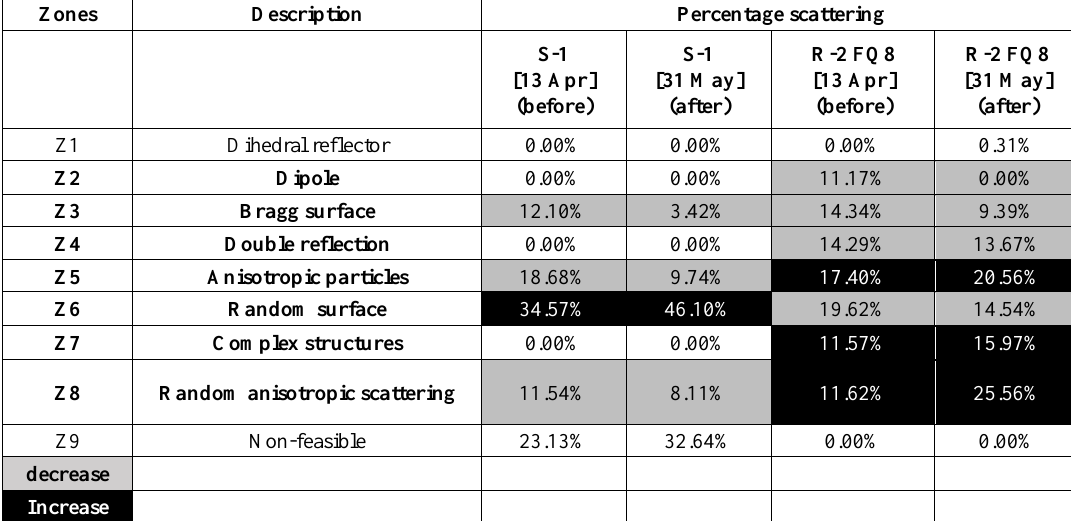
Figure 5. H-α classification planes from before and after lodging image pairs derived using same date (a), (b) Sentinel-1 (13 April, 31 May) and (c), (d) high incidence angle RADARSAT-2 FQ21 (13 April, 31 May) data